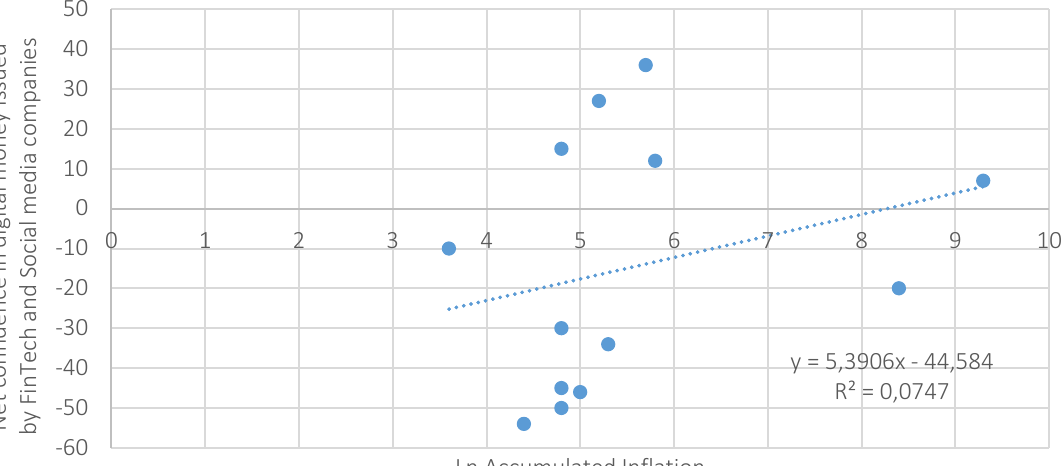
Figure D2. Confidence in privately issued digital money and inflationary